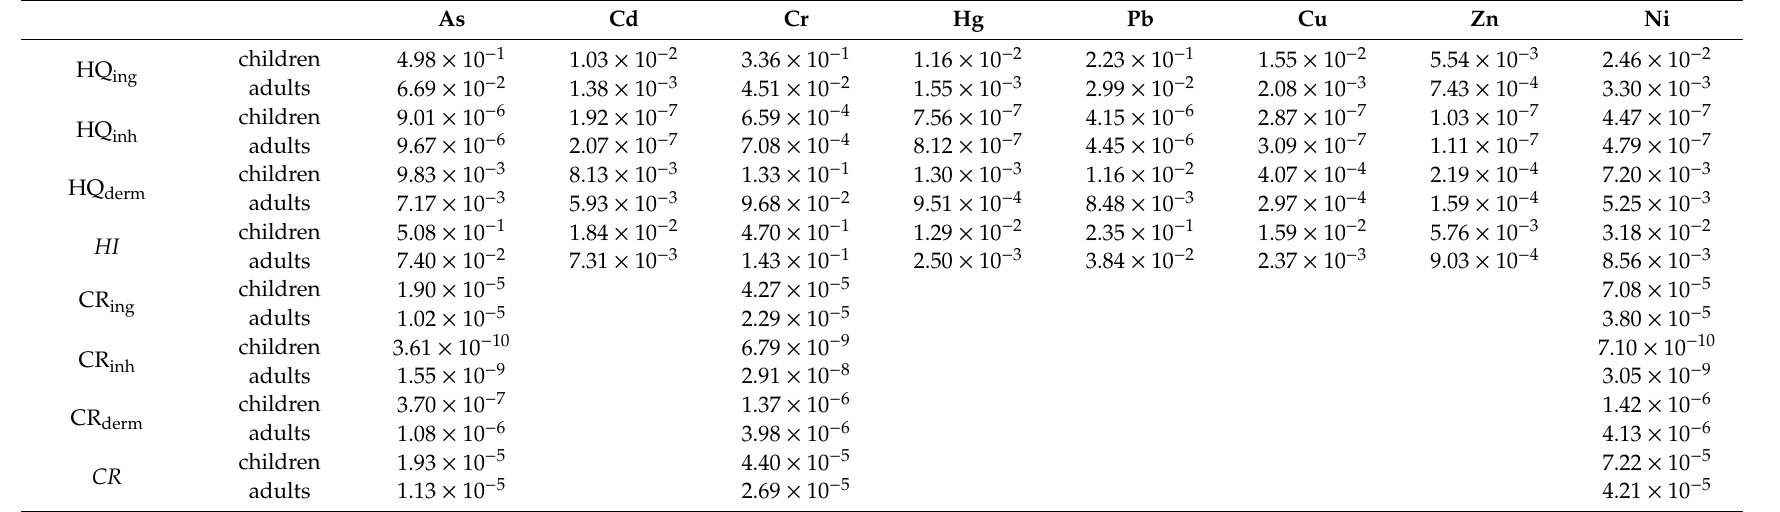
Table 4. The mean values of the human health risks for children and adults posed by each element, according to exposure pathway. As Cd Cr Hg Pb Cu Ni HQ